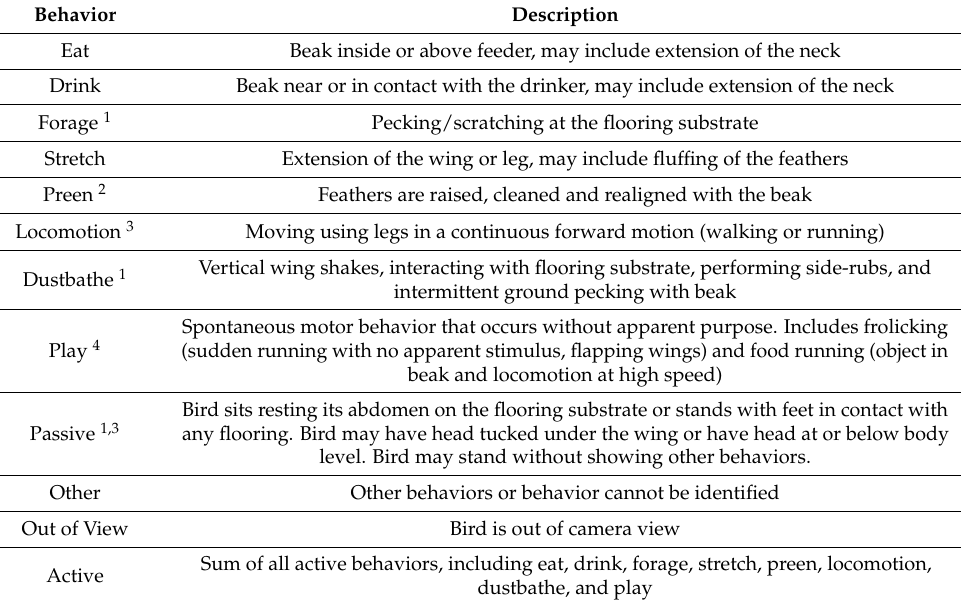
Table 1. Ethogram of recorded broiler chicken